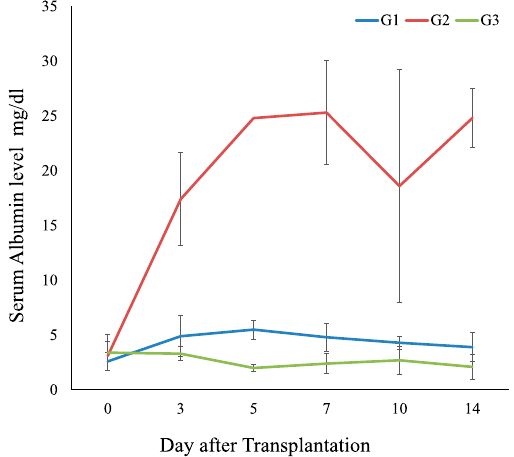
Figure 4 Serum albumin levels: Purification of cells functioning by transplantation. G1 group: without cancer cells using FACS (NHaF; n =4; 1×10 5 cells); G2 group: primary hepatocytes (PHs; n =4; 1×10 5 cells); G3 group, sham (control) operation ( n =4; DMEM). The G2 group recieved intrasplenic transplantations of 1×10 5 PH into NARs. Serum albumin levels did not significantly differ between the groups with and without transplantation initially; but significantly differed between NHaF (G1: 4.9±1.8 mg/dL; G2: 17.4±4.2 mg/dL; G3: 3.3±0.6 mg/dL) at one week after transplantation or sham operation ( P <0.001).